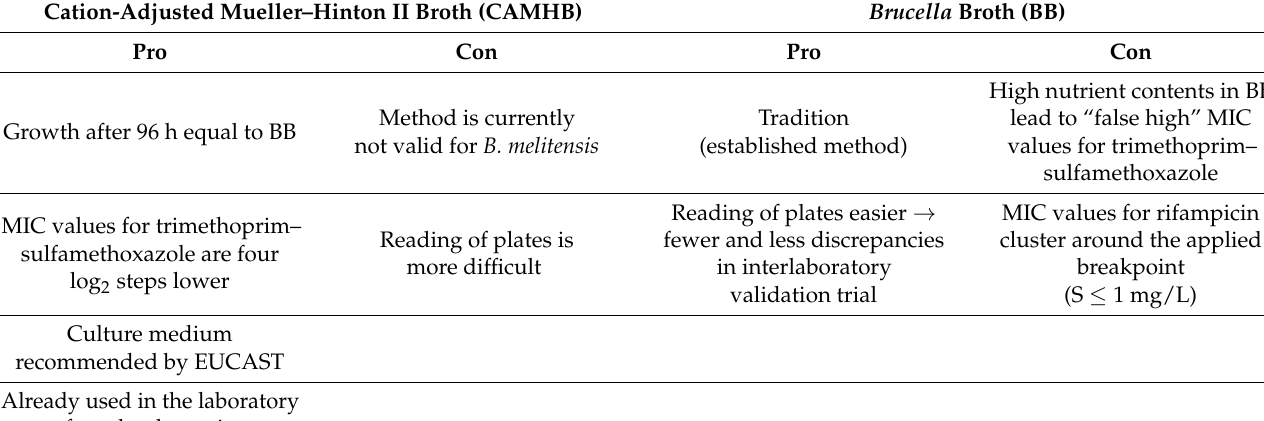
Table 2. Summary of the pros and cons of using CAMHB instead of BB as a culture medium for the AST of B. melitensis